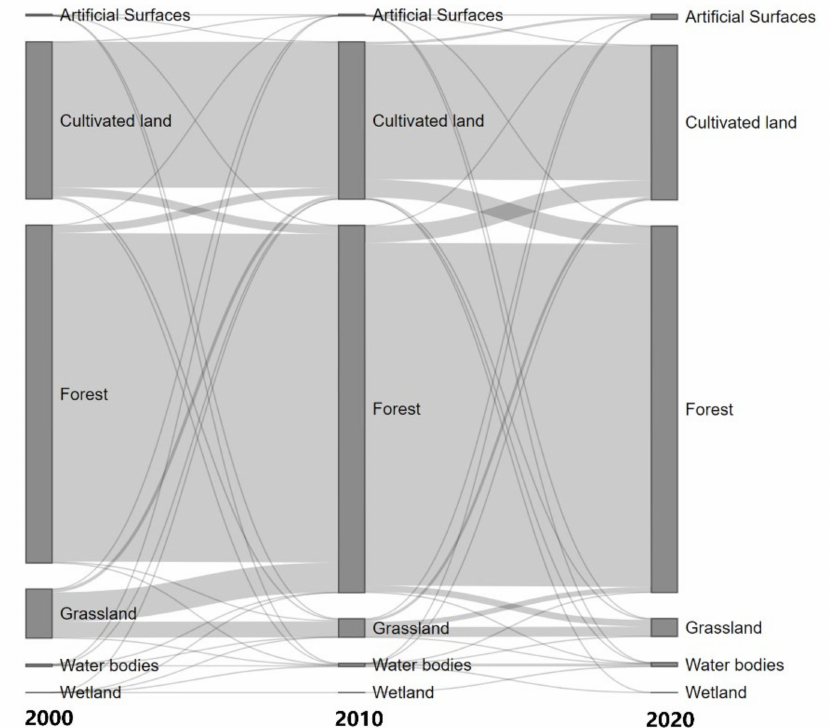
Figure 3. Land-use changes between categories in Enshi Prefecture from 2000 to 2020.